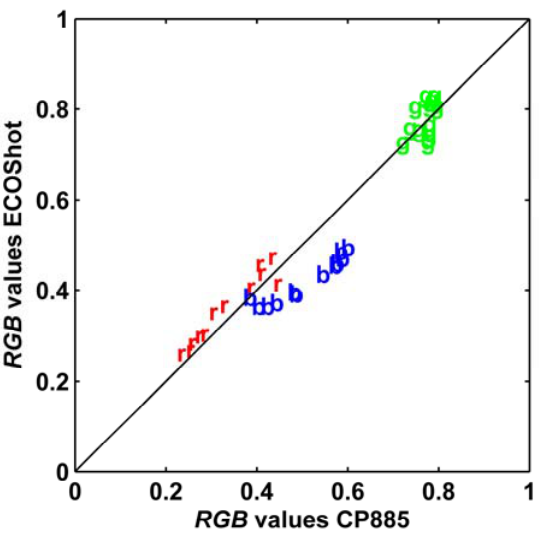
= 400) values obtained with an ECOshot against Figure 9. Scatter plot of RGB ( I tot obtained with a CP885, scaled to unity, derived from images of Galway Bay surface water ( r = red, g = green and b = blue). The line indicates a one-to-one